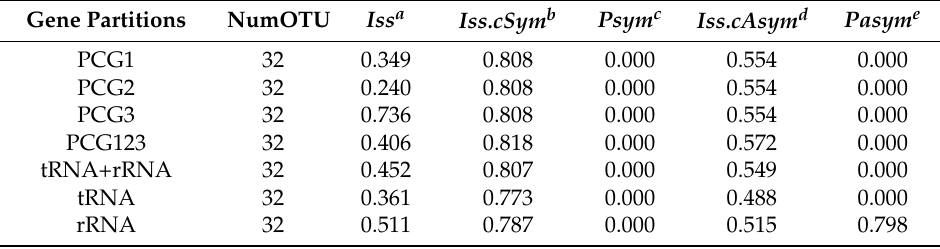
Table 3. Substitution saturations measured by DAMBE using Xia’s method.